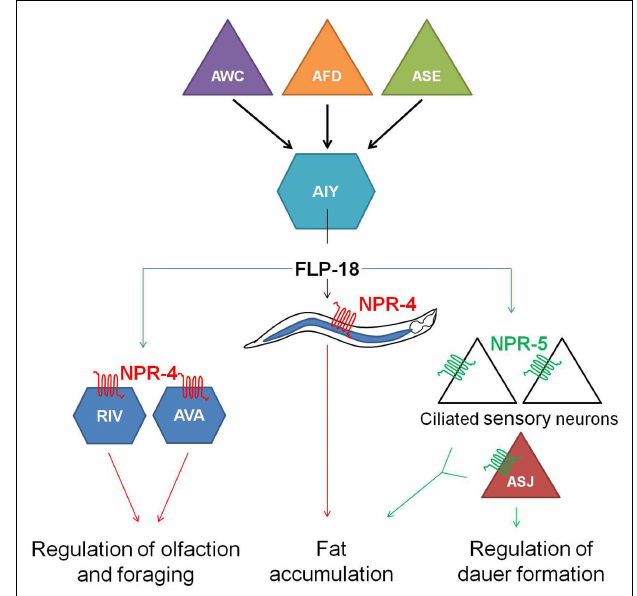
FIGURE 4 | Hypothetical model in which the detection of nutrition by sensory neurons (AWC,AFD, andASE) is coupled to the release of FLP-18 neuropeptides fromAIY interneurons and subsequent signaling through the RFamide-like receptors NPR-4 and NPR-5. By acting on NPR-4 in the intestine and NPR-5 in ciliated neurons, FLP-18 neuropeptides control fat storage. Signaling through NPR-4 in RIV and AVA neurons also modulates responses to odor and foraging behavior. Another food-dependent decision, dauer formation, is regulated by FLP-18 action on NPR-5 in the ASJ neurons (figure adapted from Cohen et al.,